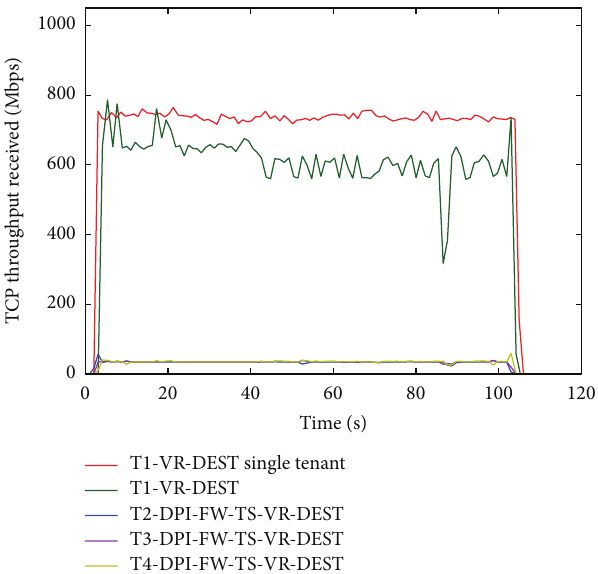
Figure 20: Received TCP throughput for each tenant (T1, T2, T3, and T4) when T1 does not traverse the VNF chain of Figure 7(d). Comparison with the single tenant case. DPI: deep packet inspec- tion; FW: firewall/NAT; TS: traffic shaper; VR: virtual router; DEST: